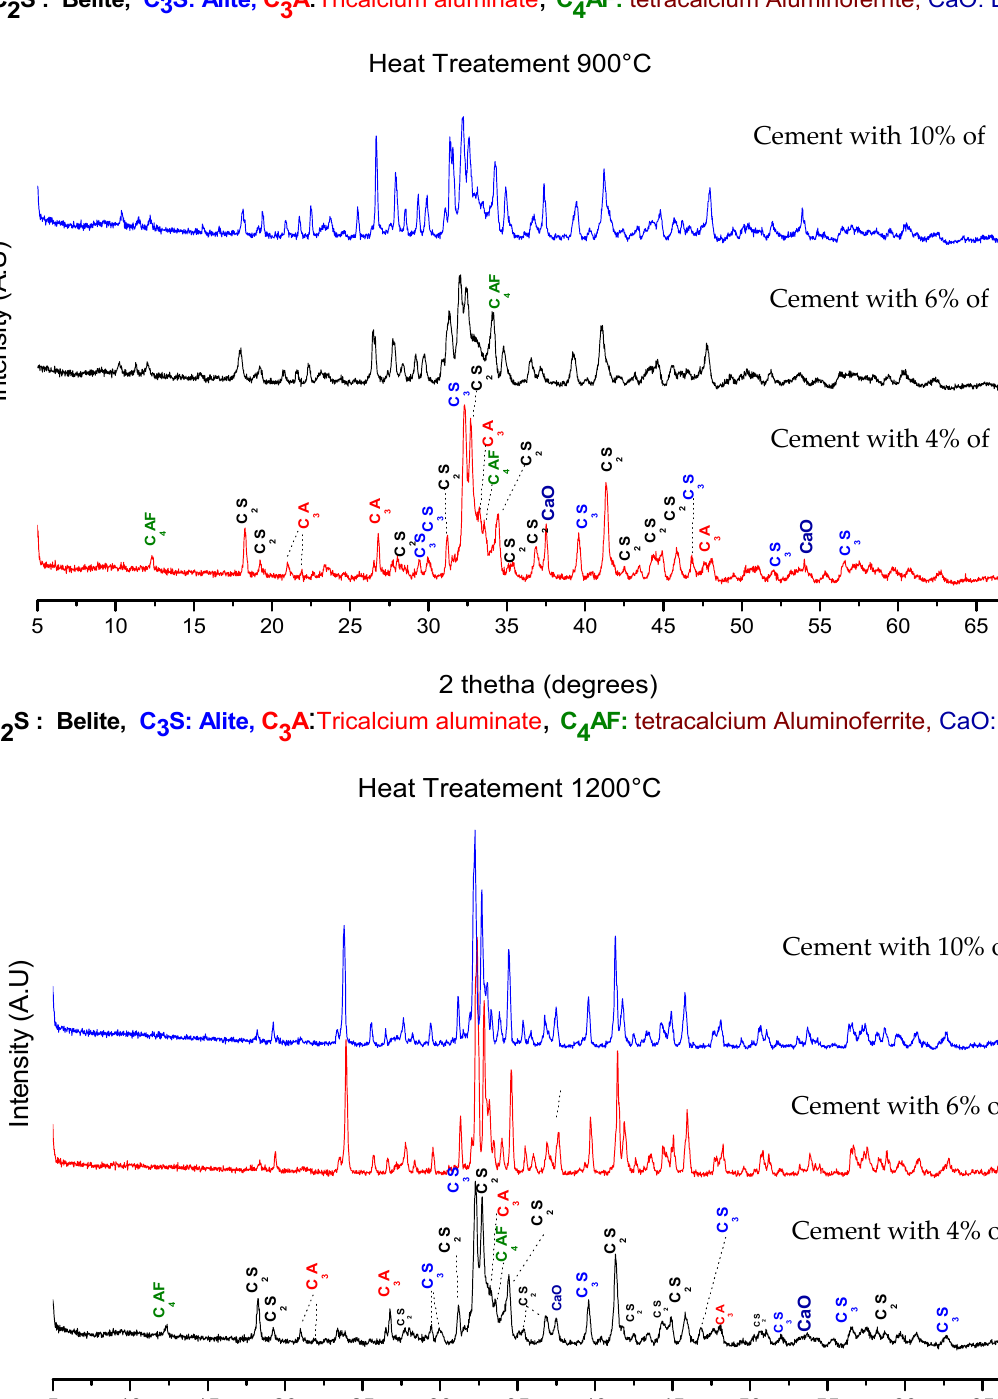
Figure 8. Phases quantifications of the anhydre cement produced by indirect mechanosynthesis. It is observed that the production of C 3 S was low whatever the temperature or the amount of 𝐶𝑆 used in order to produce cement. For the production of C 3 A, it was found that the production was also small. Concerning the production of C 4 AF, a significant amount was obtained for all the cement produced at 900 °C 15.04%, 17.03%, 16.55%, respectively, for 4%, 6%, 10% of 𝐶𝑆